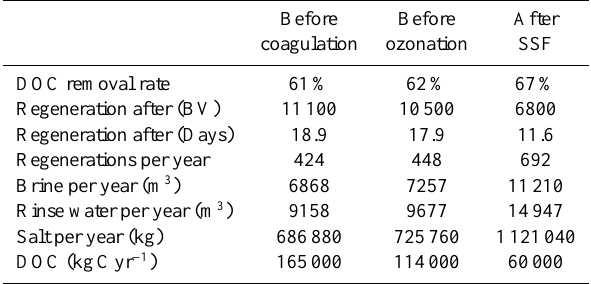
Table 4. Regeneration and waste characteristics of three possible positions for the IEX plant in the treatment